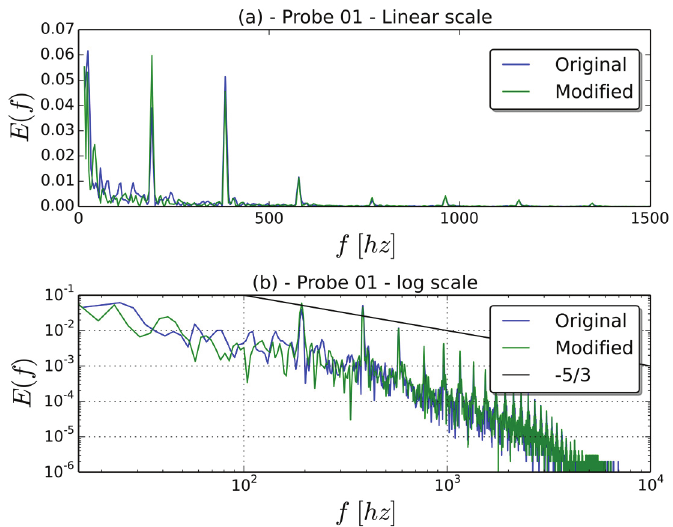
Figure 31 - Energy spectra for probe 1 . Left: in linear scale; right: log scale.